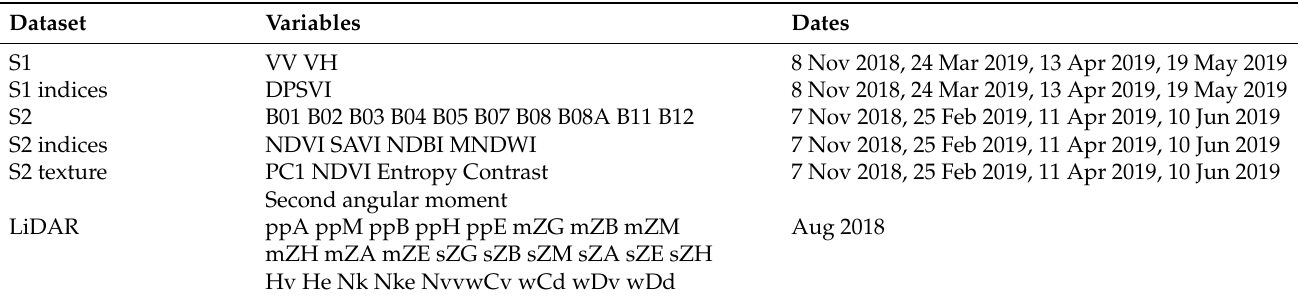
Table 3. Summary of the datasets. The names of the features are formed by combining the name of the layer and its